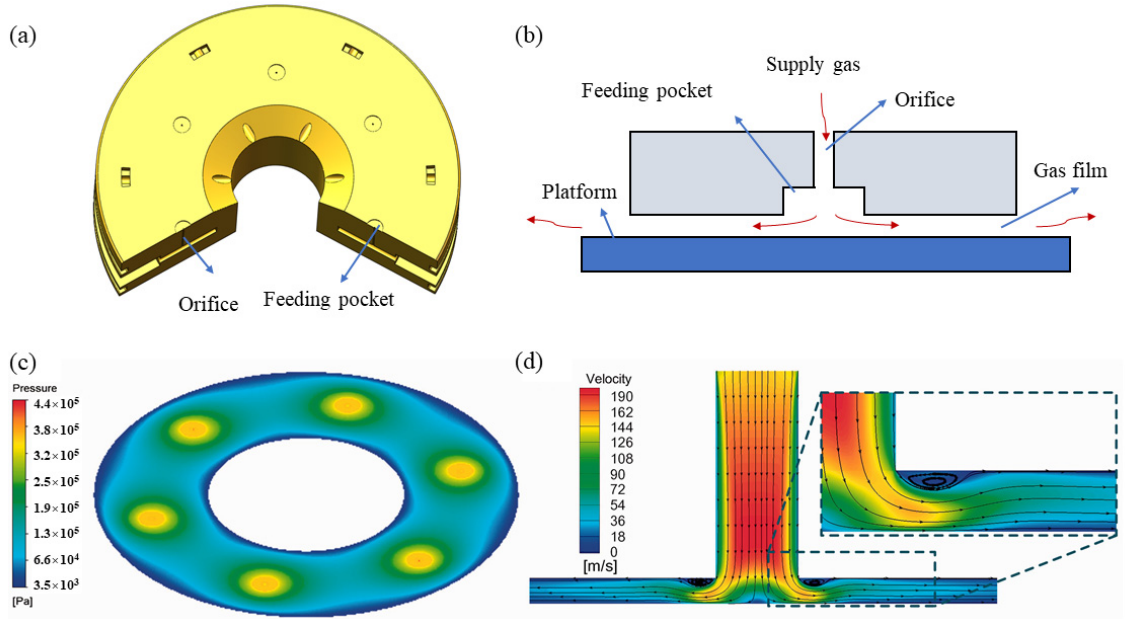
Figure 1. Schematic of ATB, pressure distribution, and velocity distribution: ( a ) schematic of ATB, ( b ) operation principle of ATB, ( c ) pressure distribution in ATB [1], ( d ) velocity contour near the orifice [1].